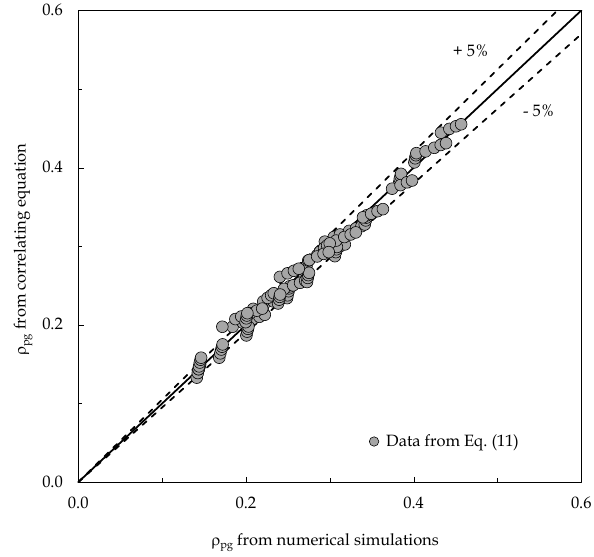
Figure 13. Comparison between Equation (11) and the numerical data obtained for ρ pg .